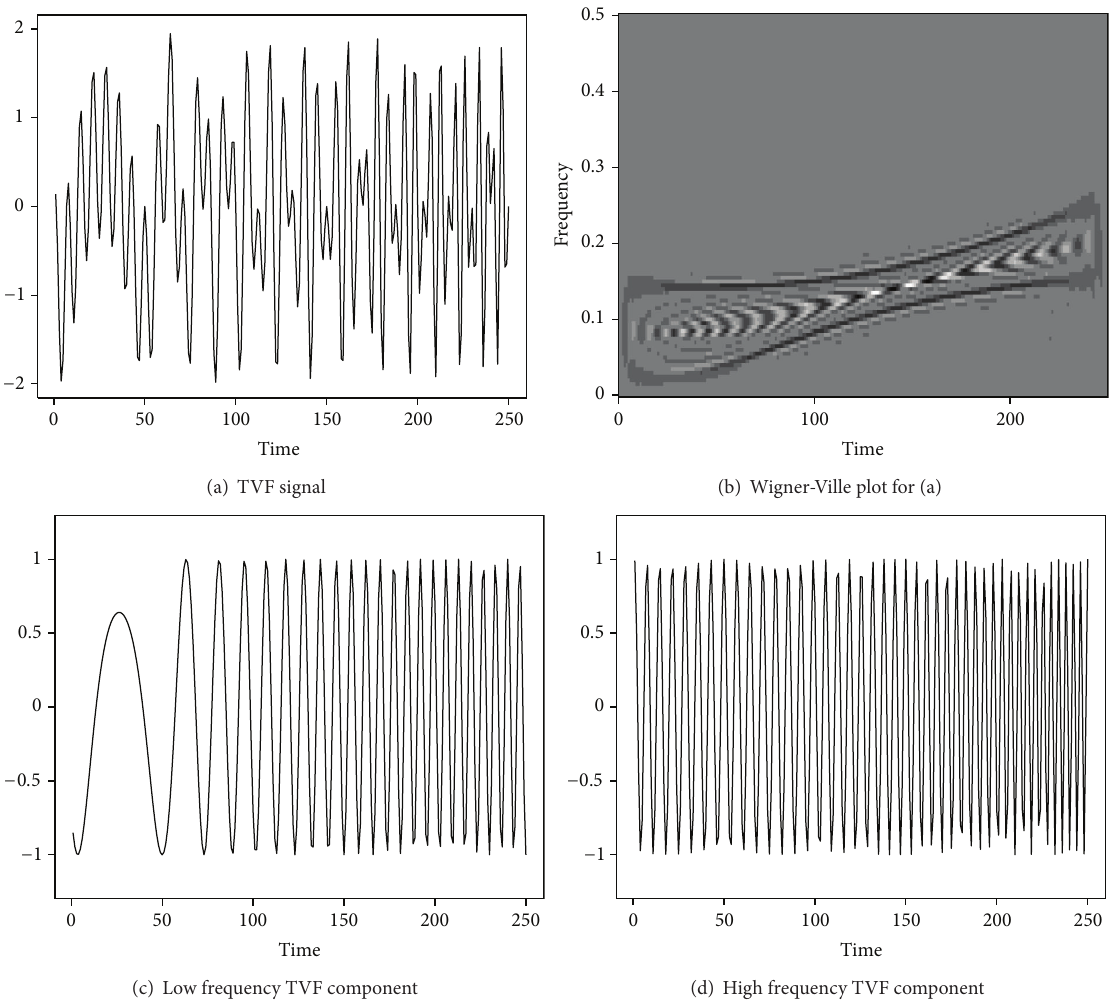
Figure 4: (a) A realization of the process in Example 4; (b) the Wigner-Ville time-frequency distribution of the data; (c), (d) the two